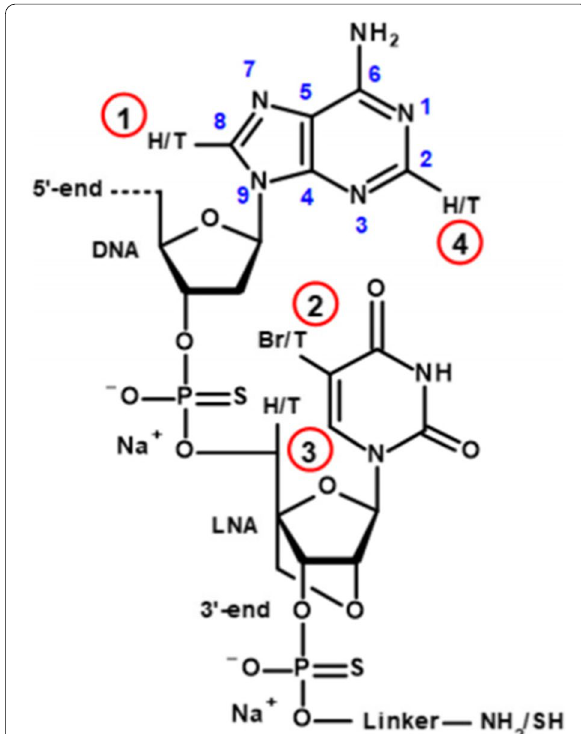
Fig. 1 Schematic structure of two nucleotides linked together with a phosphorothioate bridge. Starting from the 5 ′ -end: DNA-based adenosine and LNA-based uridine derivative. The standard numbering convention is shown on the purine ring in blue numbers from 1 through 9 on the aromatic base. Thiol or amine functionalized linker (Fig. 2) is connected to phosphorothioate at 3 ′ -end. The circled numbers represent the labeling approaches: (1) hydrogen-tritium exchange by the use of tritiated water or tritium gas and ruthenium nanoparticles, (2) palladium catalyzed bromo-tritium exchange, (3) oxidation of 5 ′ -alcohol and reduction with sodium borotritide, and (4) hydrogen-tritium exchange by the use of tritium gas and ruthenium